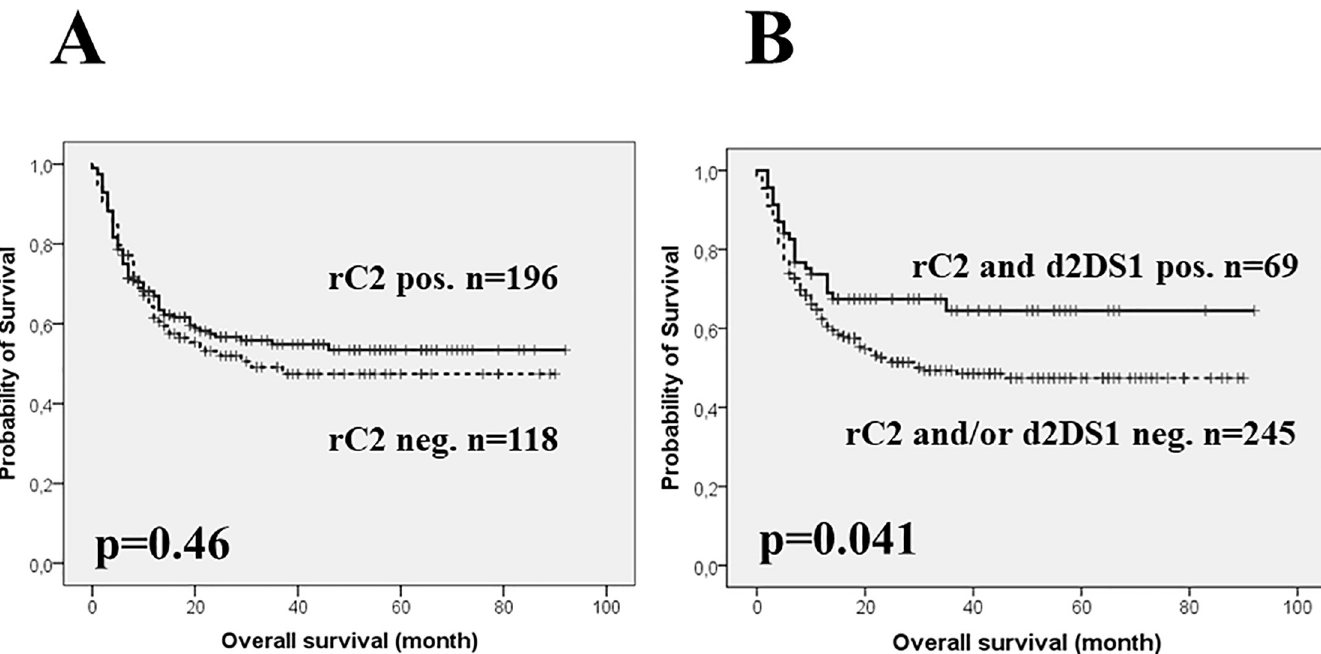
Fig 1. Overall survival of the entire allo-HSCT cohort (n = 314) according to recipient HLA-C2 group allele positivity (panel A) and combined presence of recipient HLA-C2 + donor KIR2DS1 (panel B). Survival analyses were performed by the Kaplan-Meier method and compared with the log rank test with probability (p) values and subgroup case numbers indicated. In panel A, solid line = recipients with 1 or 2 HLA-C2 group alleles (n = 196), dashed line = recipients with homozygous HLA-C1 group alleles (n = 118). In panel B, solid line = recipients with 1 or 2 HLA-C2 group alleles + donors with KIR2DS1 genotype (n = 69), dashed line = recipients with homozygous HLA-C1 group alleles and KIR2DS1 positive donor + recipients with 1 or 2 HLA-C2 group alleles and lack of KIR2DS1 in the donor (n = 127). Abbreviations: d2DS1 = donor KIR2DS1 gene, pos = positive, neg = negative, rC2 = recipient HLA-C2 group allele.